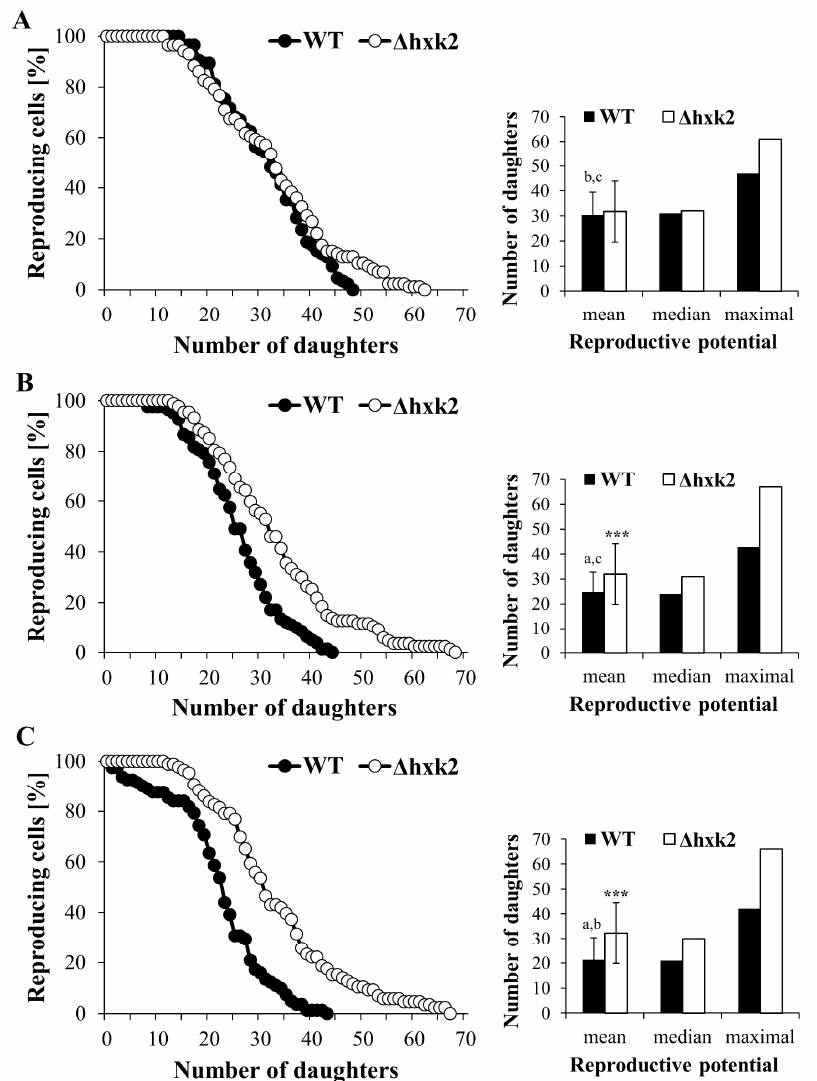
Figure 1. Reproductive potential of yeast cells cultured in conditions with different glucose concentration. ( A ) Reproductive potential of yeast cells growing in calorie restriction (CR) conditions, ( B ) reproductive potential of yeast cells growing in optimal conditions ( C ) reproductive potential of yeast cells growing in calorie excess (CE) conditions, The data represent the mean values from two independent experiments of 40 cells each. *** p < 0.001 as compared with the WT strain; a—different to medium with 0.5% glucose, b—different to medium with 2% glucose, c—different to medium with 4% glucose.